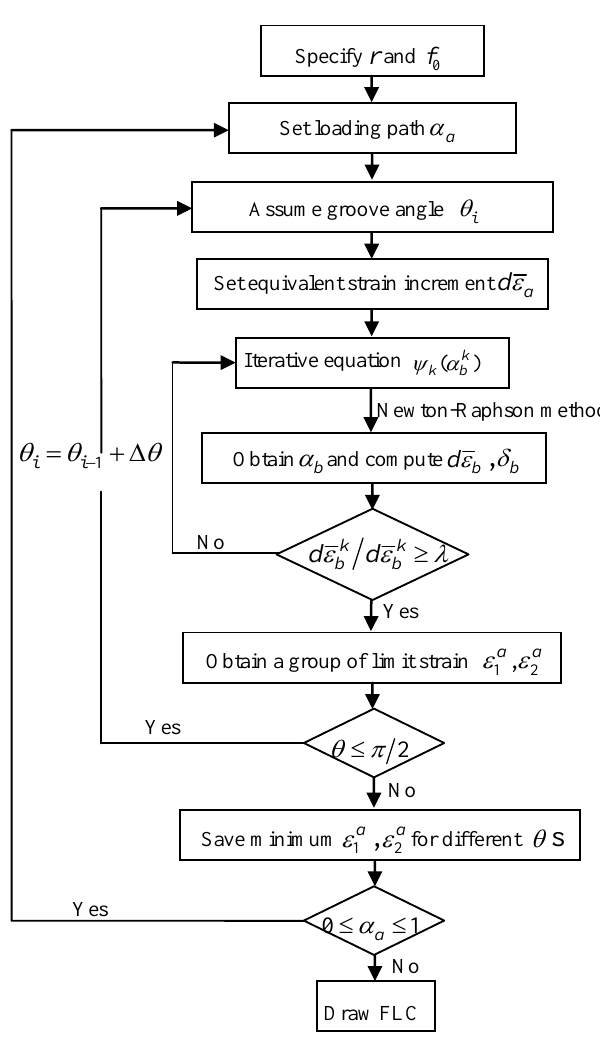
Figure 4. Flow chart of computing process for forming limit curve (FLC).